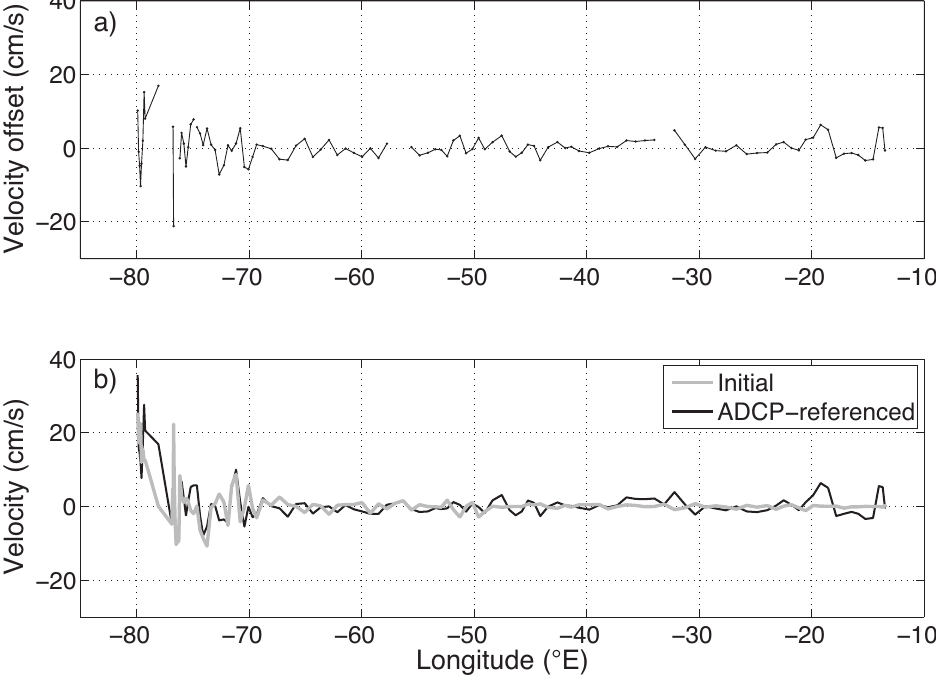
Fig . 6. – a) velocity obtained from the depth-averaged offset of each geostrophic profile, considered as the reference velocity providing the new corrected calculations; b) final velocity estimated at the sea bottom before (grey line) and after (black line) the referencing ADCP data contribution was taken into